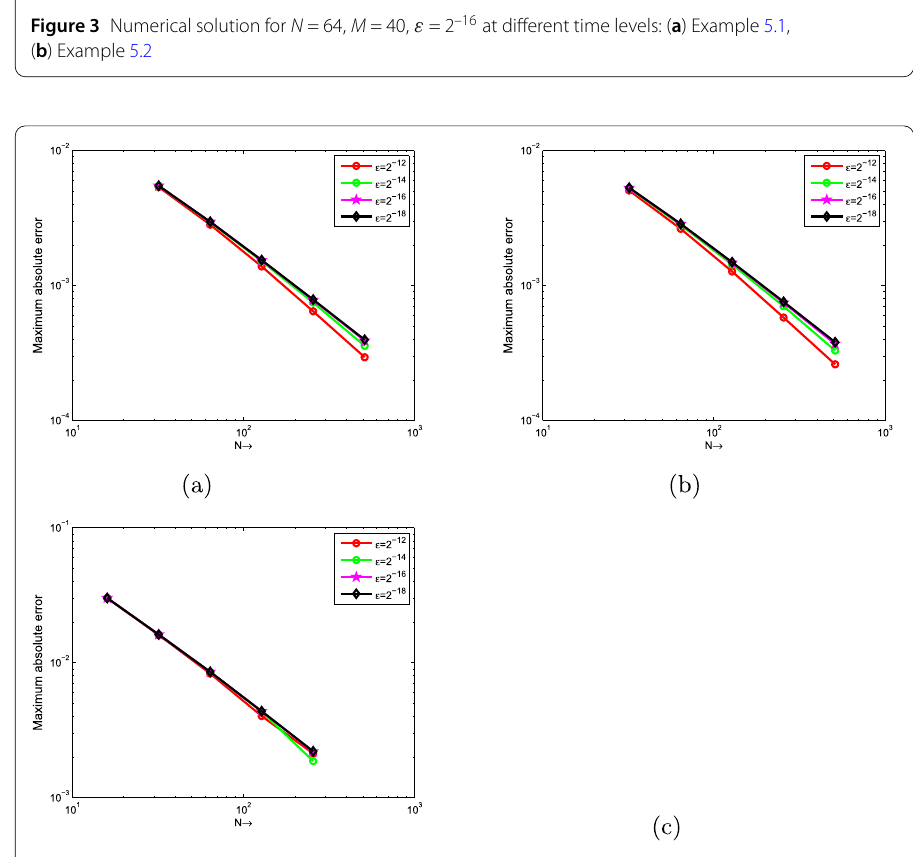
Figure 4 Example 5.1 ( a ), Example 5.2 ( b ), and Example 5.3 ( c ): log-log scale plots of the maximum absolute errors for different values of